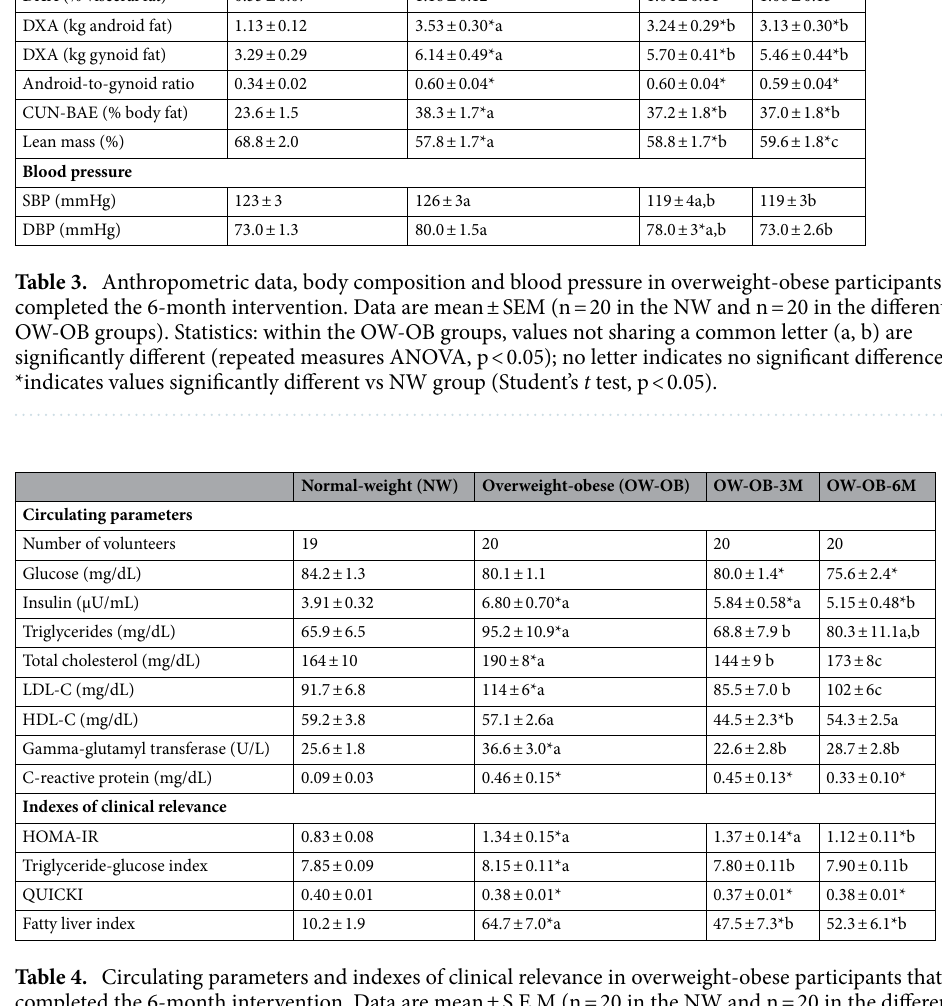
the 6‑month weight‑loss plan on their expression in OW‑OB subjects. Four key genes involved in lipid metabolism were selected to be analysed at mRNA expression level in PBMC from our volunteers. Genes were: CPT1A , which plays an important role in fatty acid beta-oxidation in the mitochondria; the lipogenic FASN and SREBP-1c genes, involved in the formation of long-chain fatty acids; and PPARG , coding for a key adi-